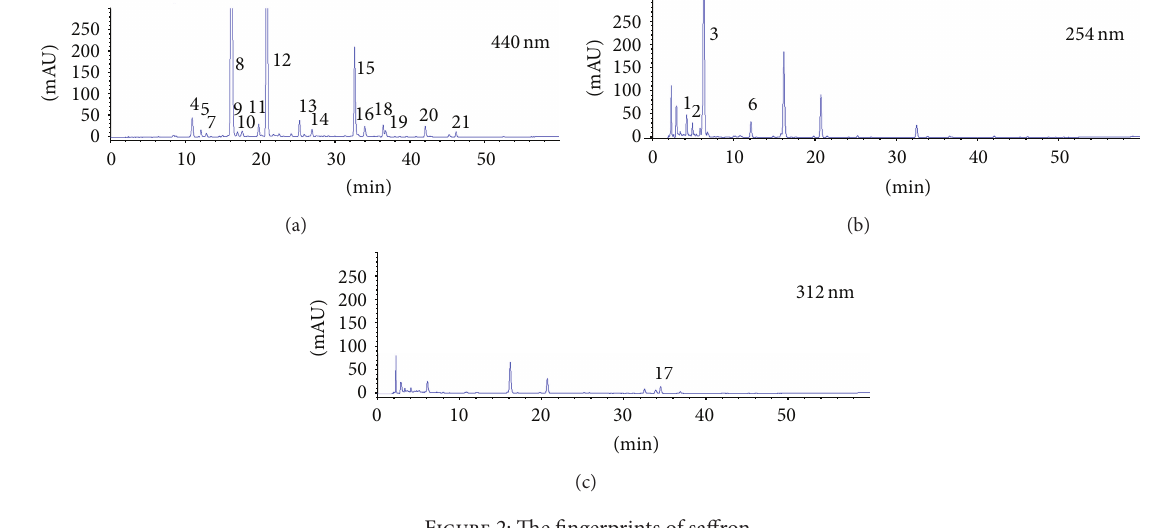
Figure 2: The fingerprints of